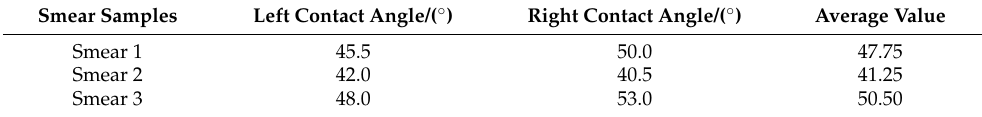
Table 4. Compound smear contact angle.